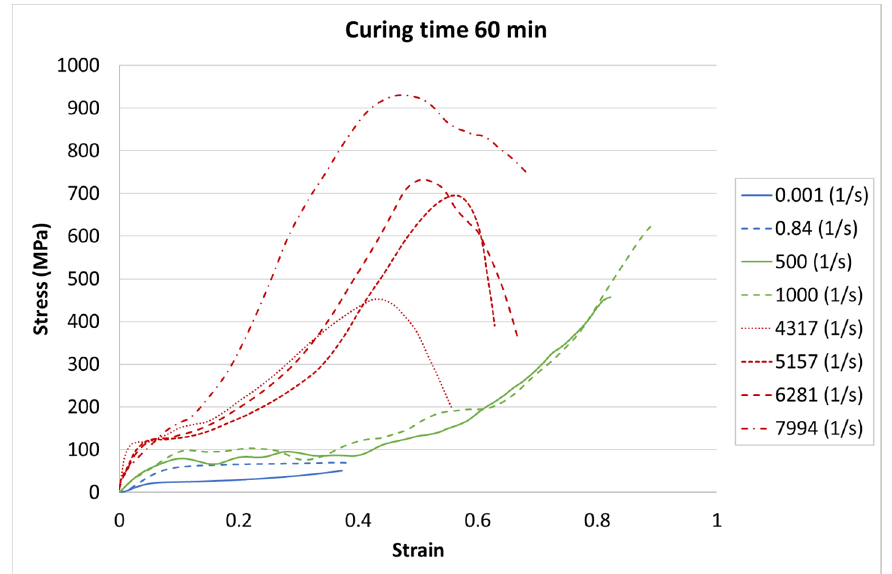
Figure 8. Results of durable resin tested under various strain rates for a curing time of 60 min for UV and heat exposure.